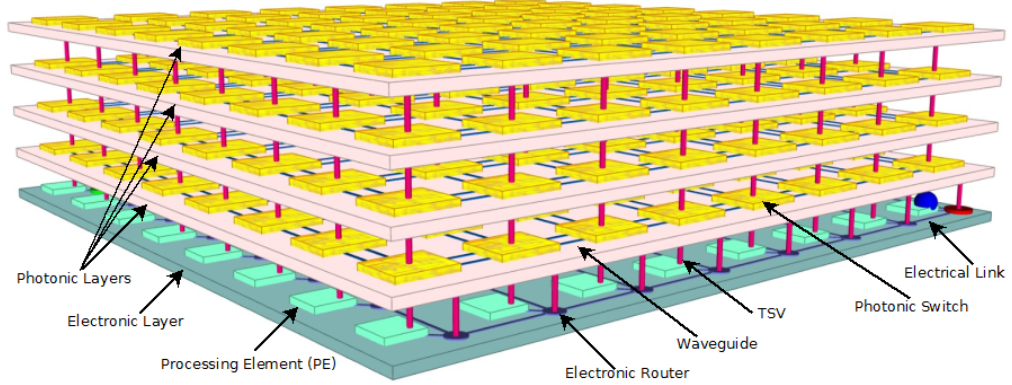
Figure 2. PHENIC-II system architecture configured with multiple photonic layers (Photonic Communication Networks (PCNs)).